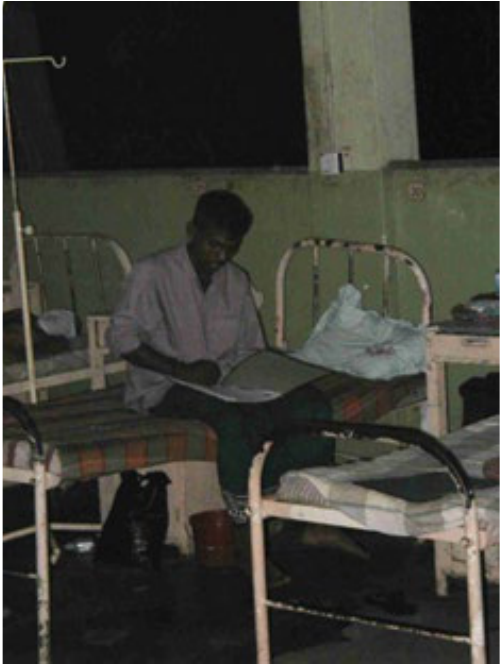
Figure 2. A study patient reading the Patient Information Sheet in his medical notes after regaining consciousness, 2002. Image by the author Michael Eddleston, with consent from the study